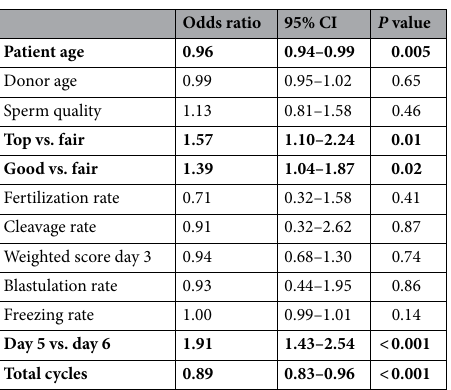
Odds ratio 95% CI P